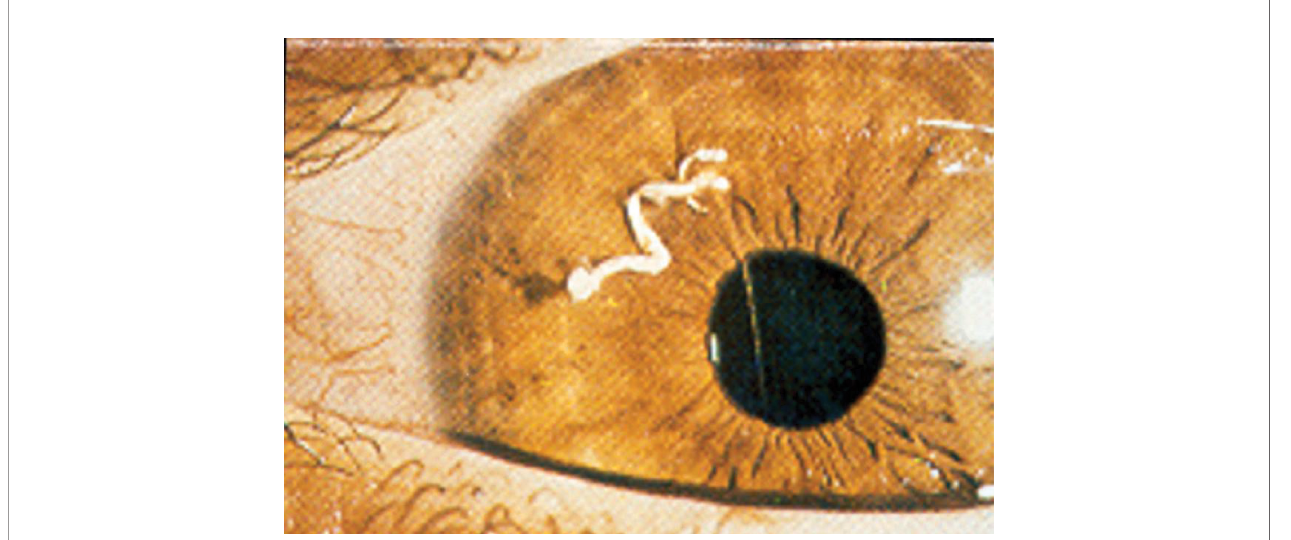
FIGURE 1 | Germinating seedling in the anterior chamber of an eight year-old boy following 10 weeks of ocular pain. The vermiform object was extirpated and identi fi ed by a botanist to be a seedling of a dicotyledonous plant. Reproduced from Abel (1) with permission from Archives